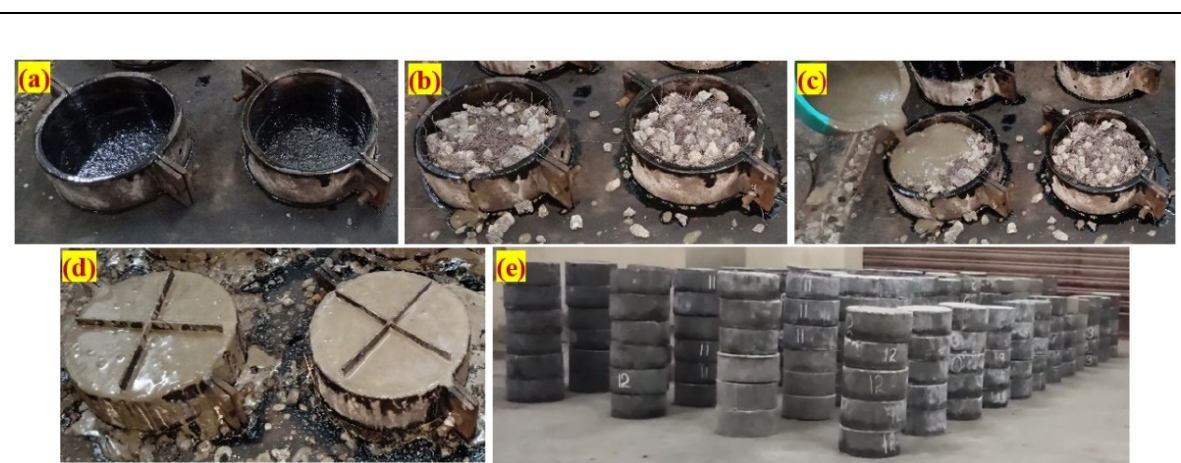
Figure 5. The fabrication method: ( a ) empty cylindrical mold; ( b ) fibres and coarse aggregate filled into the mold; ( c ) pouring of grout; ( d ) casted specimens with notch plate insertion; and ( e ) appear- ance of specimens, which were kept on the floor after demolding.